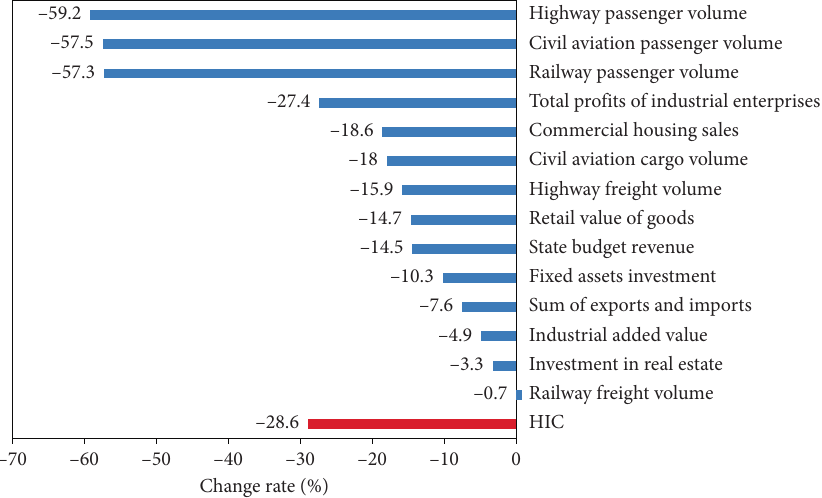
Figure 7: HIC and the year-on-year growth of socioeconomic indicators from January to April